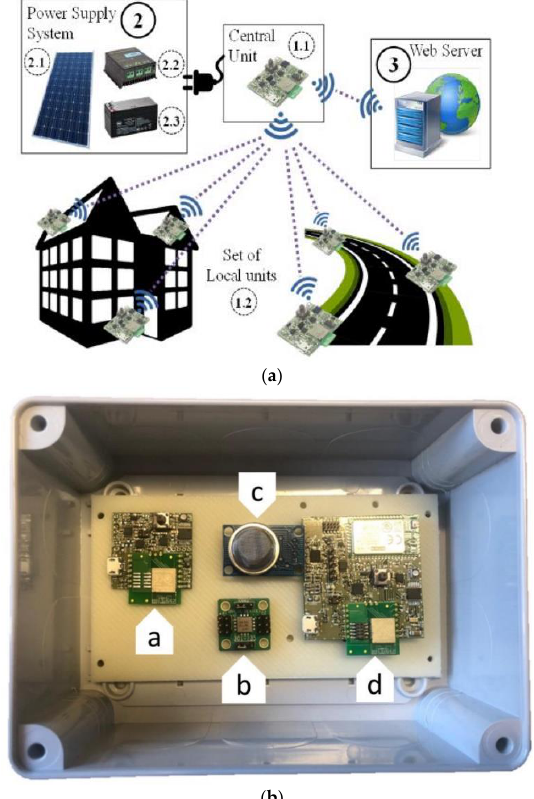
Figure 4. SICURVIA project platform: ( a ) System components and scheme; ( b ) electronic components: (a) LUME local unit, (b)-accelerometer, (c) air quality sensor, (d) HUB central control unit; [12].